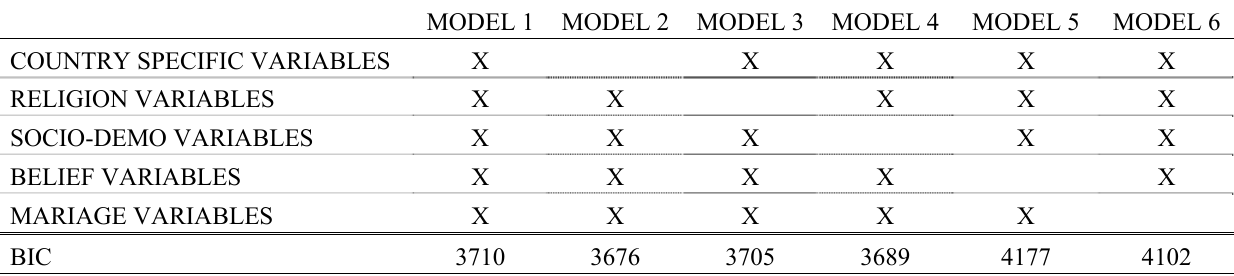
Table 5. BIC for males, all